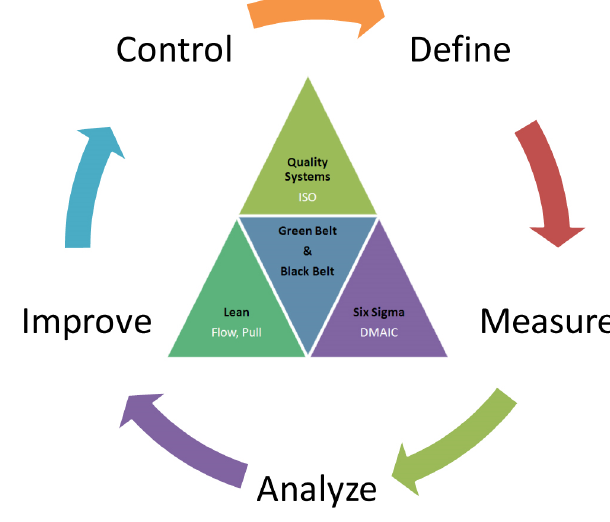
Fig. 2. The structure of Six Sigma